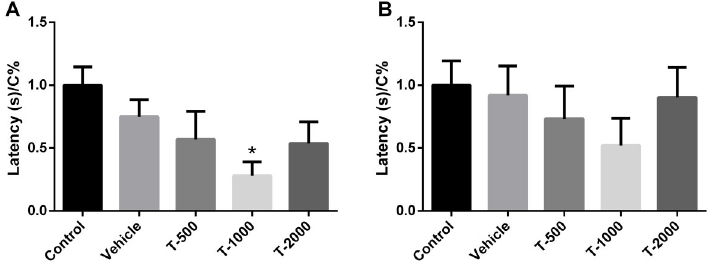
Figure 4. Long-term memory in adult offspring of mothers treated with valerian in the postpartum period. Groups: Control (1 mL distilled water), Vehicle group (1 mL distilled water, 20% of glycerol), T-500 (500 mg (cid:1) kg – 1 (cid:1) day – 1 of valerian), T-1000 (1000 mg (cid:1) kg – 1 (cid:1) day – 1 of valerian), and T-2000 (2000 mg (cid:1) kg – 1 (cid:1) day – 1 of valerian). A , Female offspring, latency time (s) performing the step-down inhibitory avoidance task (F(4, 5)=0.1603, *P o 0.01, compared to control). ( B ) Male offspring, latency time (s) performing the step down inhibitory avoidance task (F(4, 5)=1.172, P =0.4747). Data are reported as means ± SE (n=8 – 13 per group). Values in the groups were normalized to those in the control group. One-way ANOVA and Dunnett ’ s